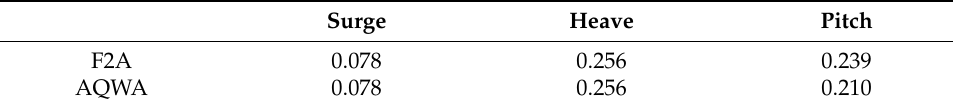
Table 4. Natural frequencies (rad/s) of platform.